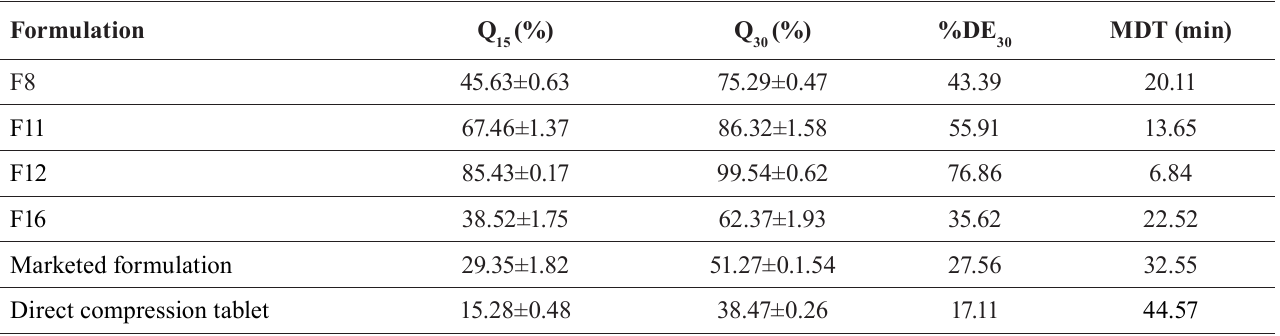
TABLE V - D issolution parameters of racecadotril formulations (Mean ± SD, n=3) Formulation